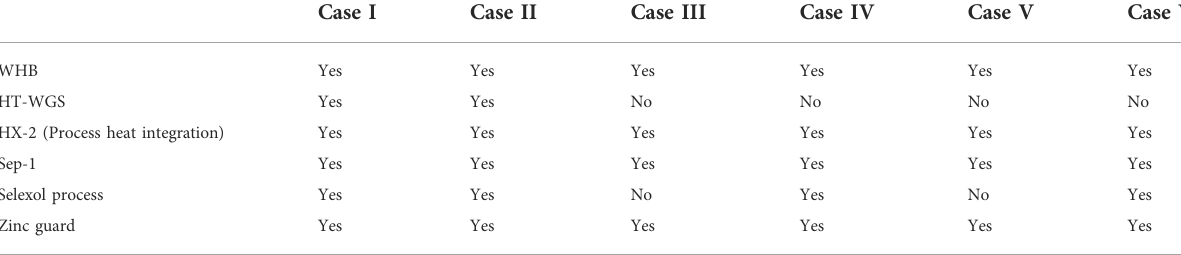
TABLE 1 Applicable process steps for Case I – VI in syngas clean-up and conditioning. Case I Case II Case III Case IV Case V Case